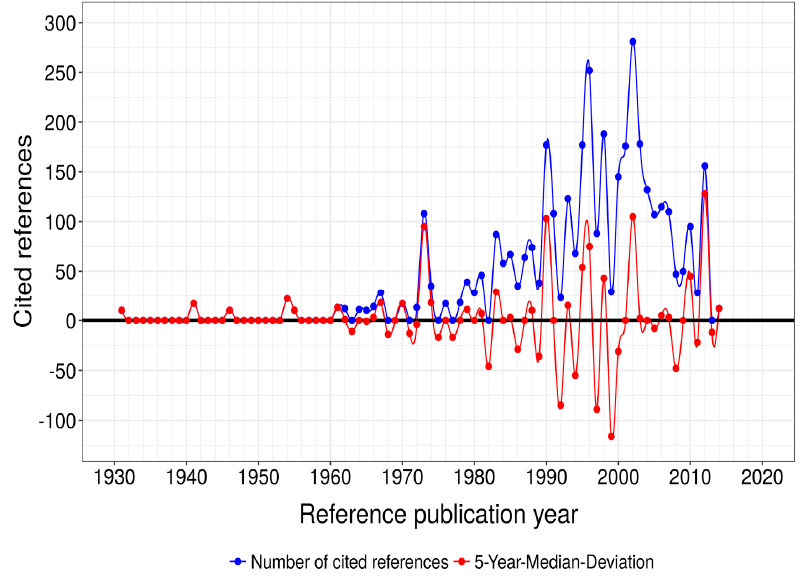
Figure 7. Annual distribution of the references cited in the publication set of 433 papers across their reference publication years 1931–2014. Blue curve: number of cited references; red curve: deviation from the median. Source: WoS, CRExplorer.